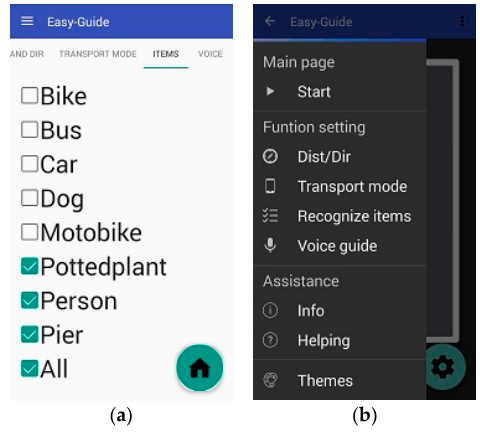
Figure 14. Snapshots of Android program: ( a ) settings page for obstacle type selection; ( b ) settings options with black background and white words.